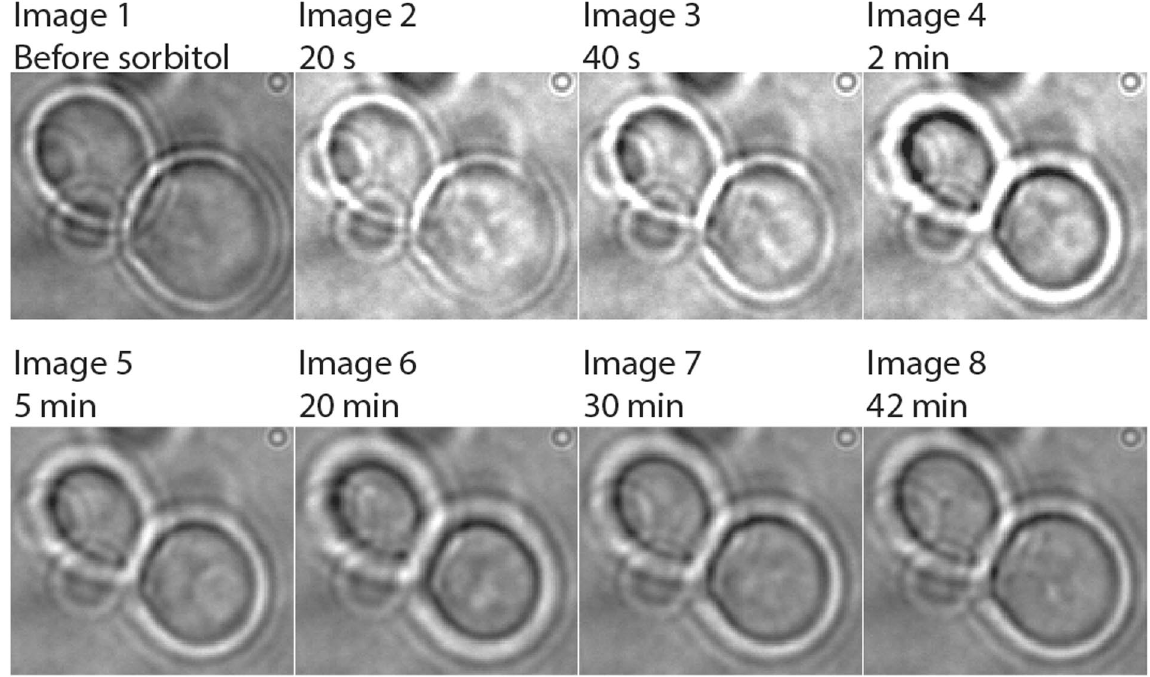
Figure 3. Effect of hyper-osmotic stress on volume of S. cerevisiae . Cells were immobilized on APTES- glutaraldehyde modified coverslips. They were imaged in media allowing growth prior to the osmotic shock. Then, media with sorbitol was added to a final concentration of sorbitol of 1 M. Upon addition of sorbitol the cells rapidly shrink (images 2–4), after which they adapt and recover their volume over a period of approximately 30